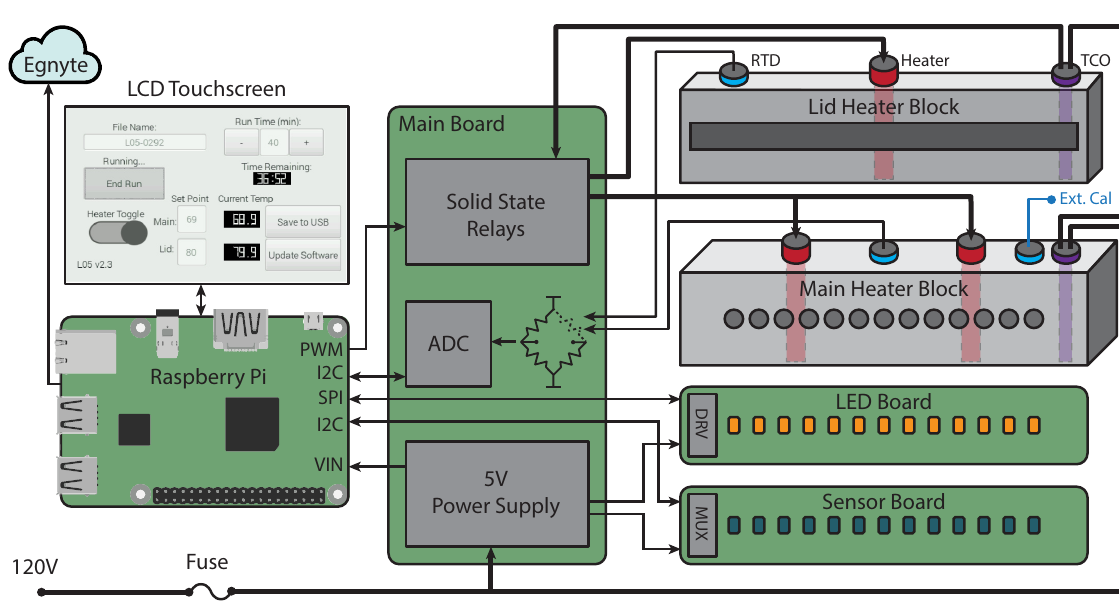
Fig 2. LARI block diagram, including all principal components and touchscreen UI